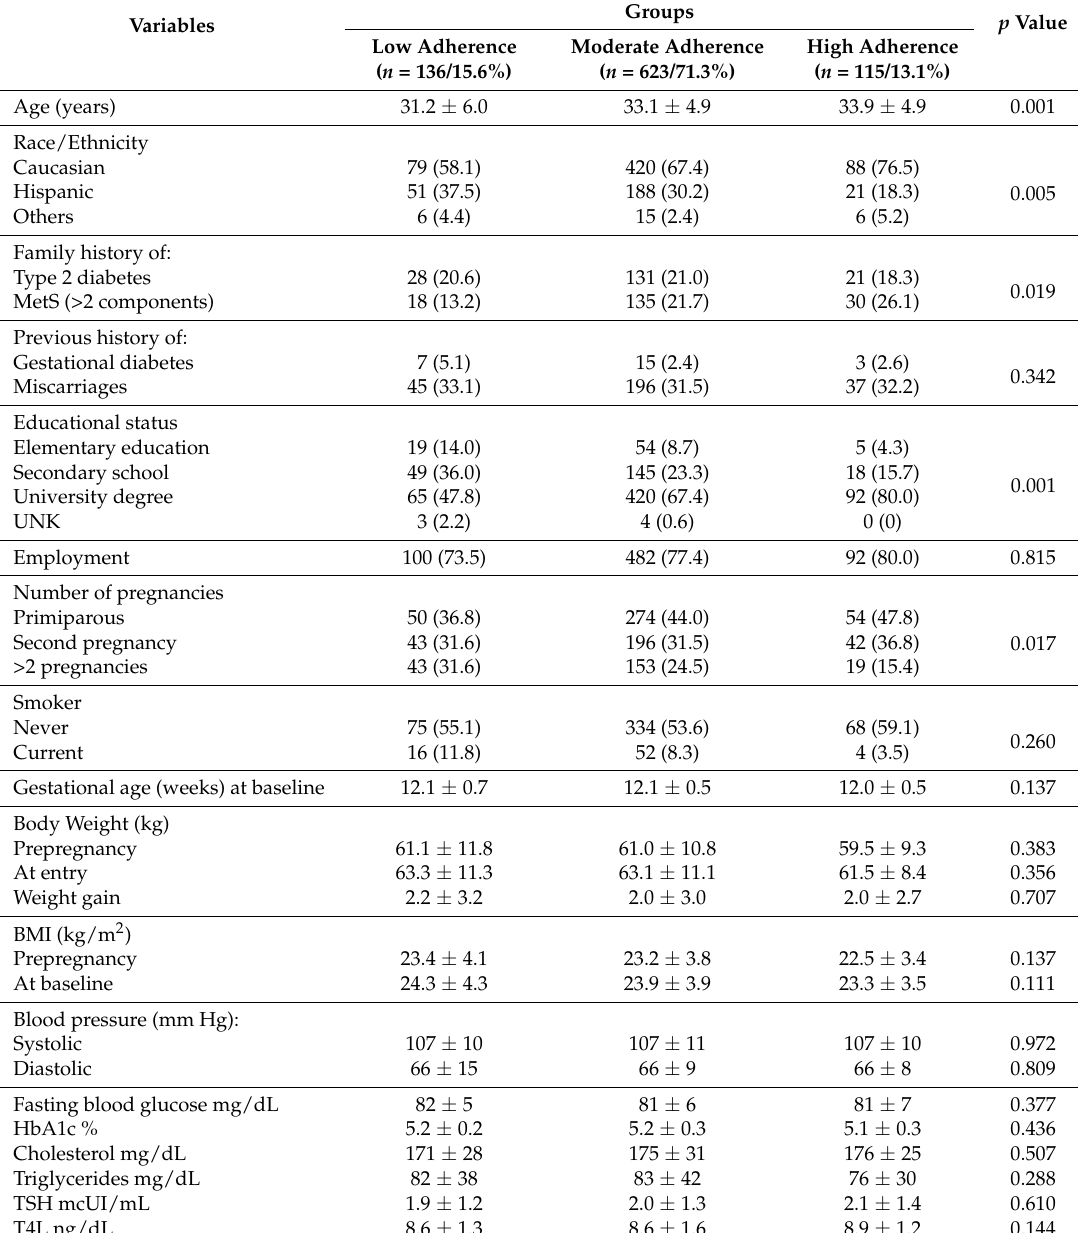
Table 3. Characteristics of the clinical trial population at baseline according to late first-trimester degrees of adherence to the six food